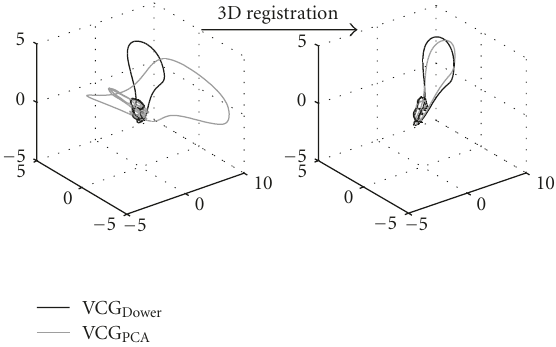
Figure 4: Comparison between the synthesized VCG loops: black line is obtained by Dower and gray line is obtained using